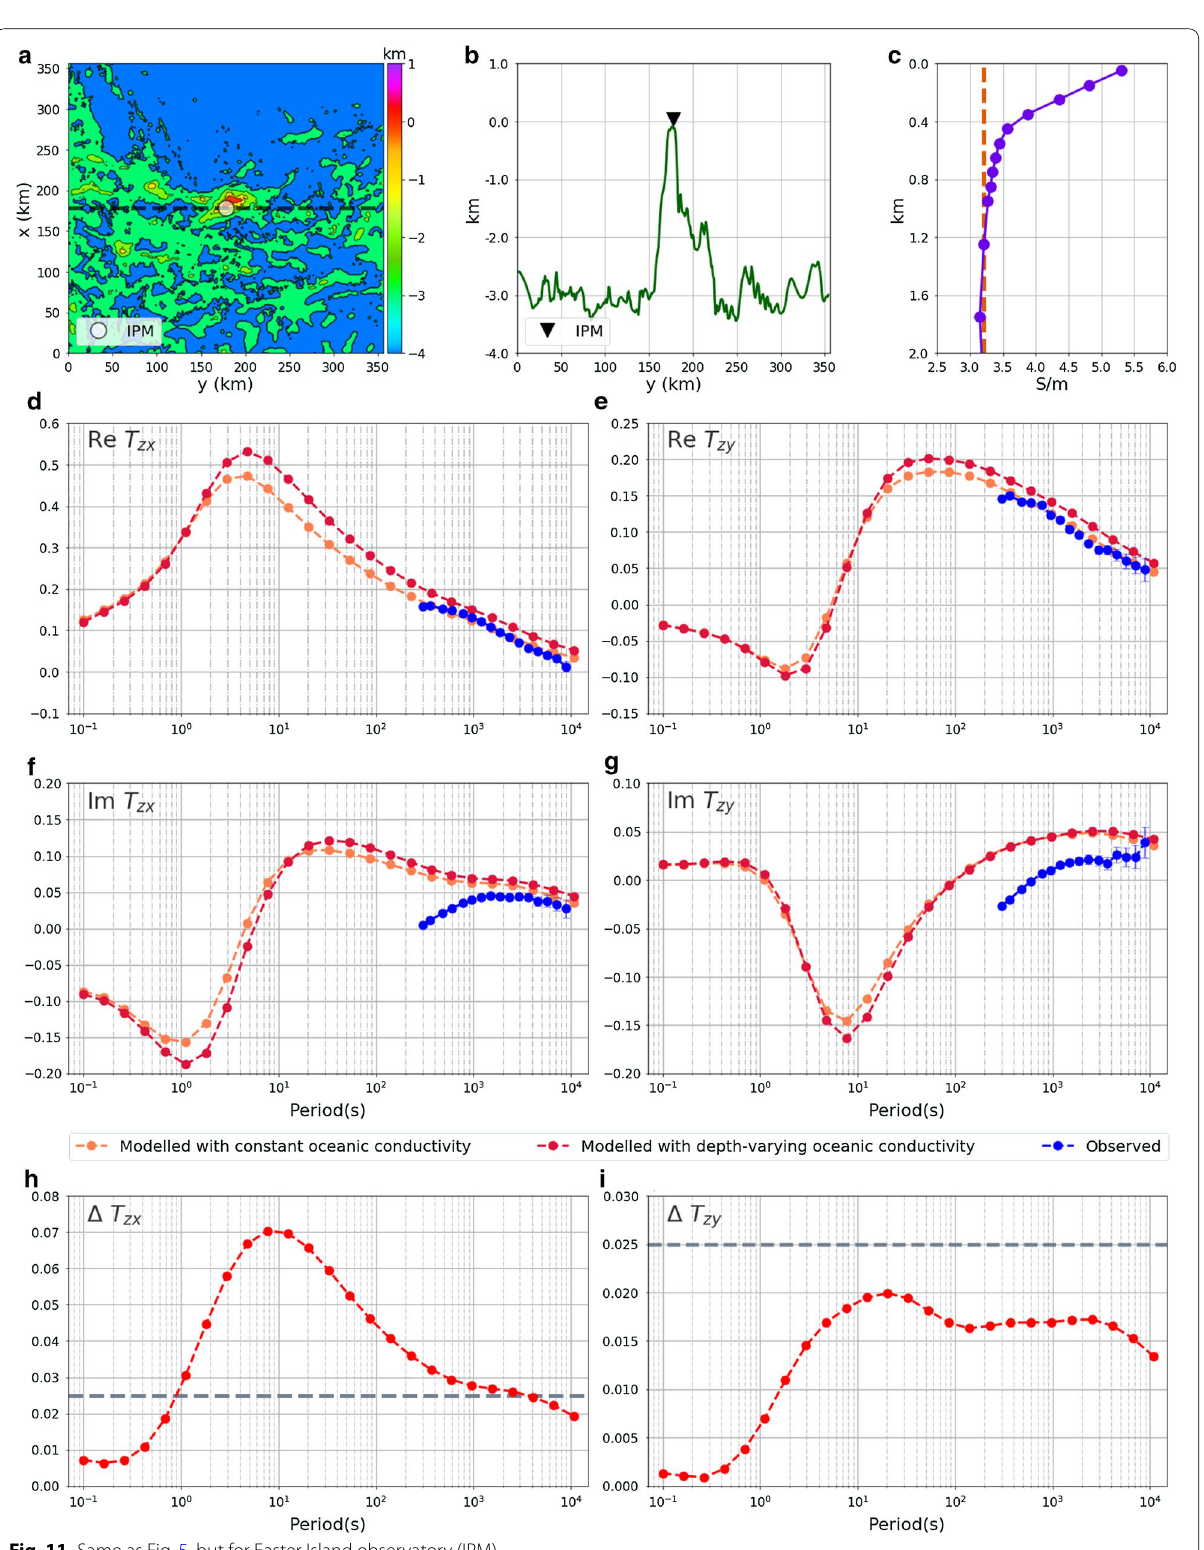
Fig. 11 Same as Fig. 5, but for Easter Island observatory